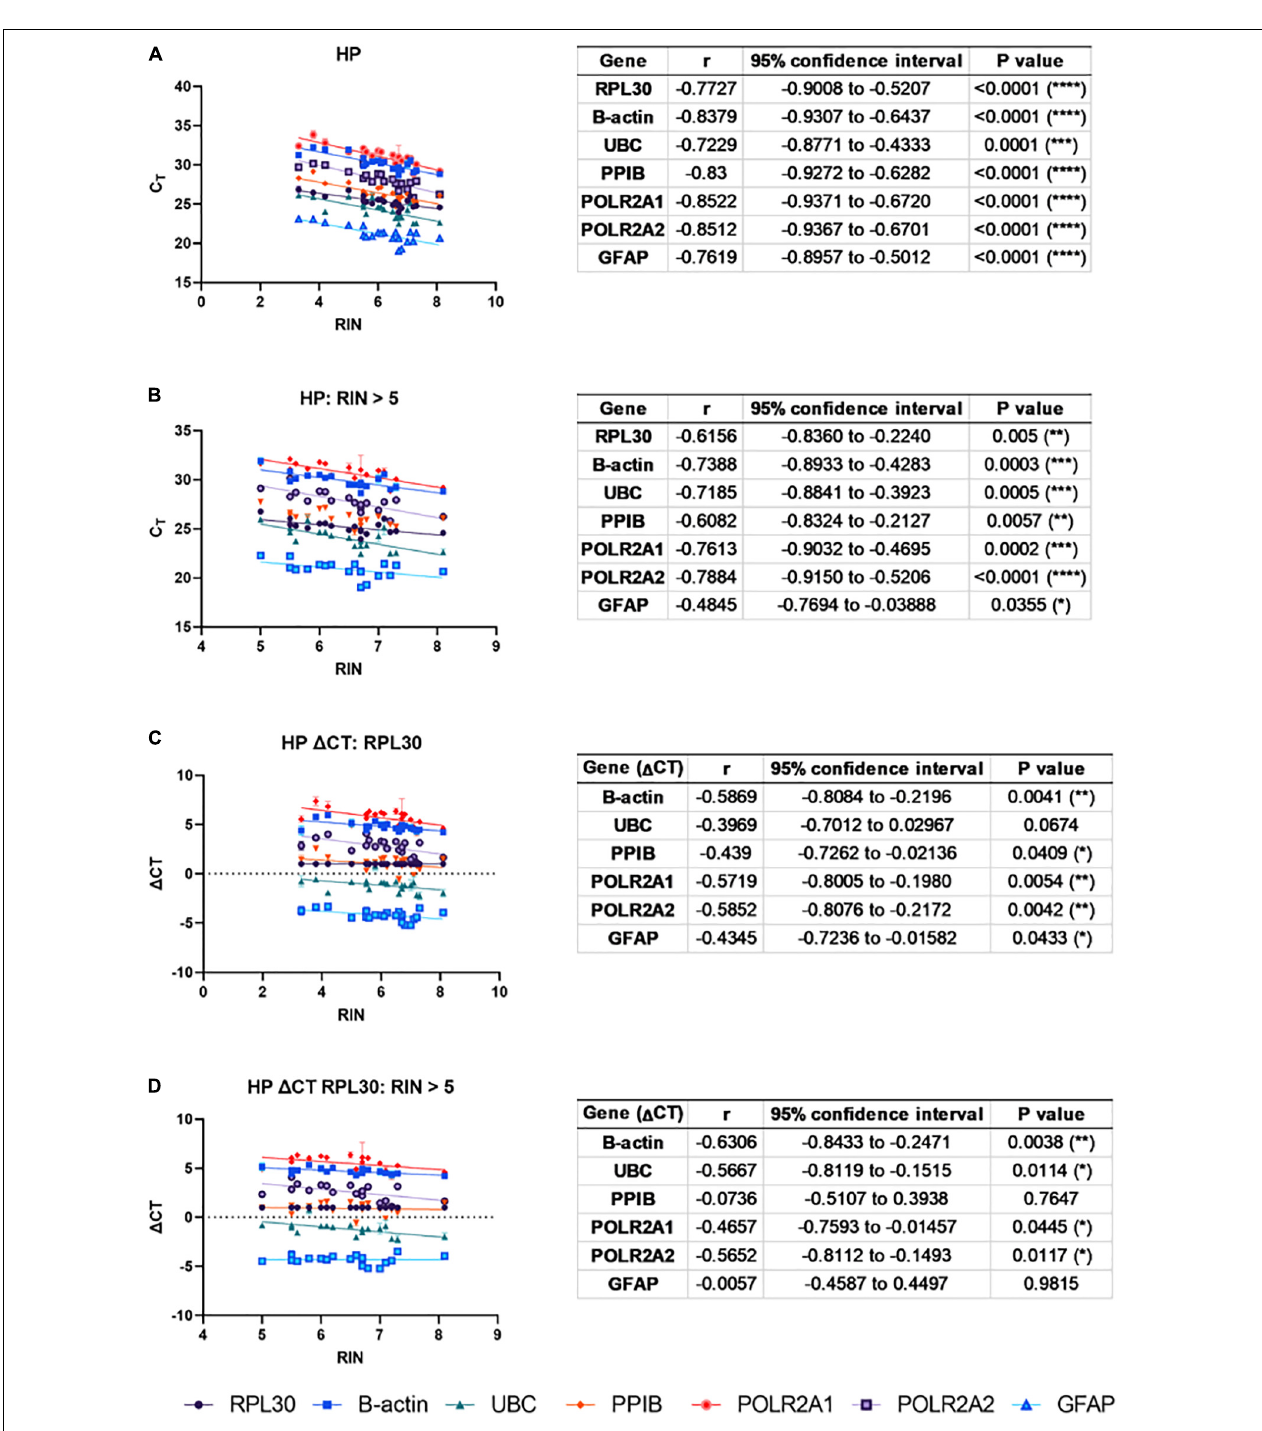
FIGURE 2 | RNA integrity number (RIN) is correlated with CT: To ascertain whether degraded total RNA affects mRNA quantification using qPCR, correlations between RIN and qPCR CT for six genes commonly used in qPCR studies of human brain tissue were made across pooled normal and AD HP cases. (A) Strong, negative correlations were observed between CT and RIN for all genes. (B) After excluding RIN values < 5, strong negative correlations were still observed for three out of six genes (B-actin, UBC, POLR2A ), moderate negative correlations were observed for two out of six genes ( RPL30, PPIB ), and GFAP showed a weak, negative correlation. To mitigate this, CT values were normalized to RPL30 using the (cid:49) CT method. (C) Moderate, negative correlations were still observed in two out of five genes ( B-actin, POLR2A ) and weak negative correlations were observed in two out of five genes ( UBC, PPIB ). (D) Removing RIN values < 5 still produced moderate, negative correlations for two out of five genes ( B-actin, UBC ), and one gene showed a moderate or weak negative correlation depending on the primer pair used (POLR2A ).